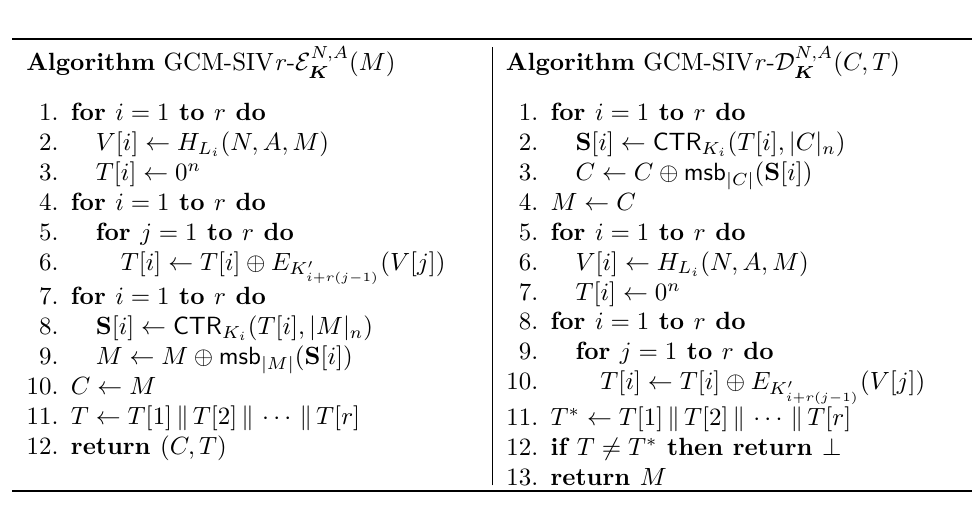
Figure 6: Definitions of GCM-SIV r - E N,A